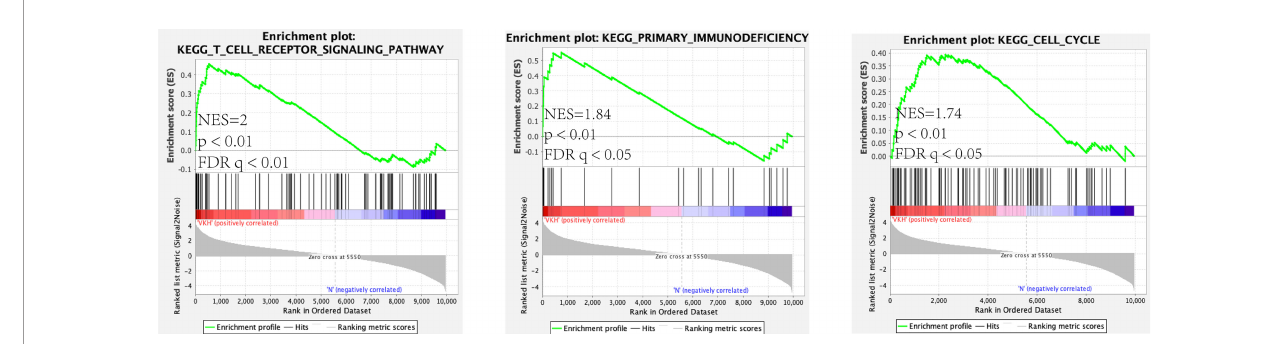
FIGURE 5 | Gene set Enrichment analysis (GSEA) for mRNA.